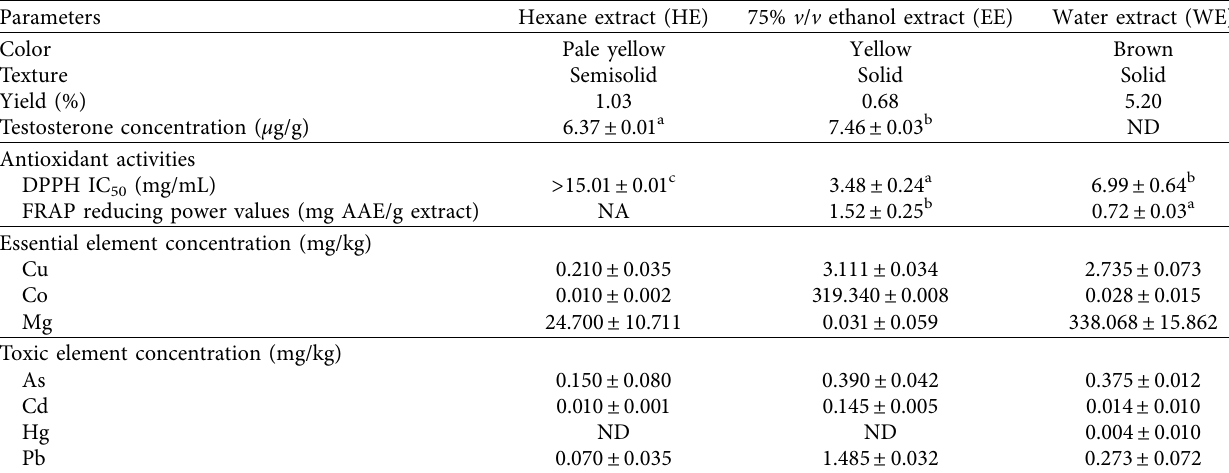
Figure 1: Velvet antler powder (a) was extracted with a three-solvent sequential extraction process to obtain hexane (b), 75% v / v ethanol (c), and water (d) extracts (HE, EE, and WE, respectively). Table 1: Color, texture, percentage yields, testosterone concentrations, antioxidant activities, and essential and toxic element concentrations of velvet antler